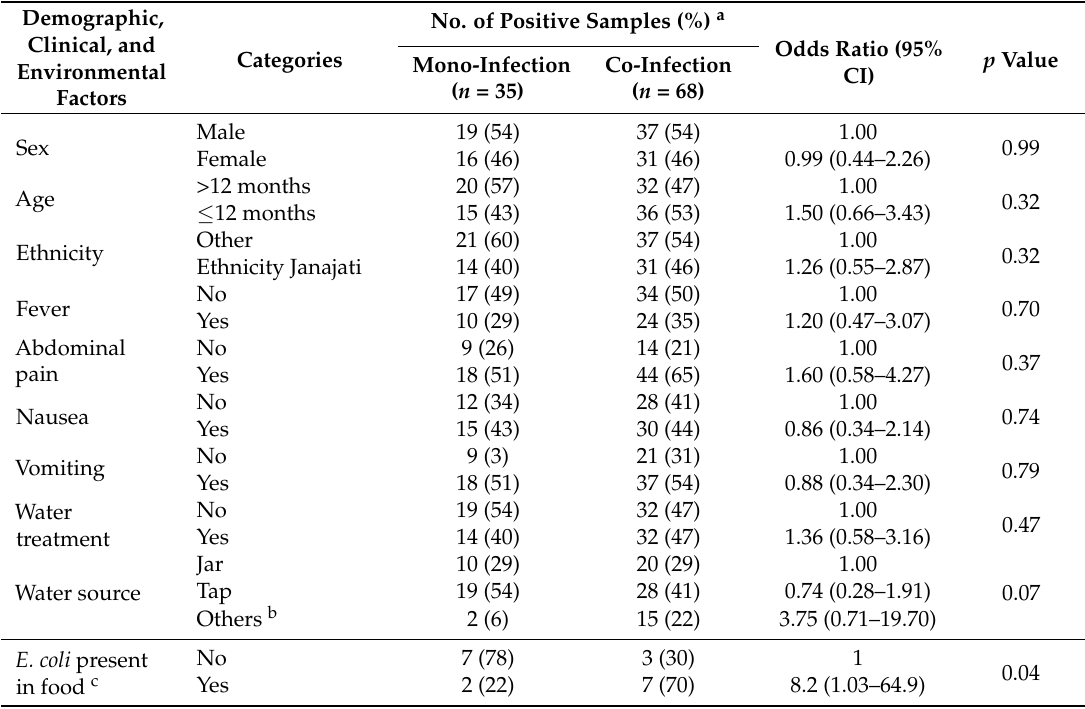
Table 6. Relationship between co-occurring virus status and demographic, clinical, and environmental factors on the basis of positive percentage of stool